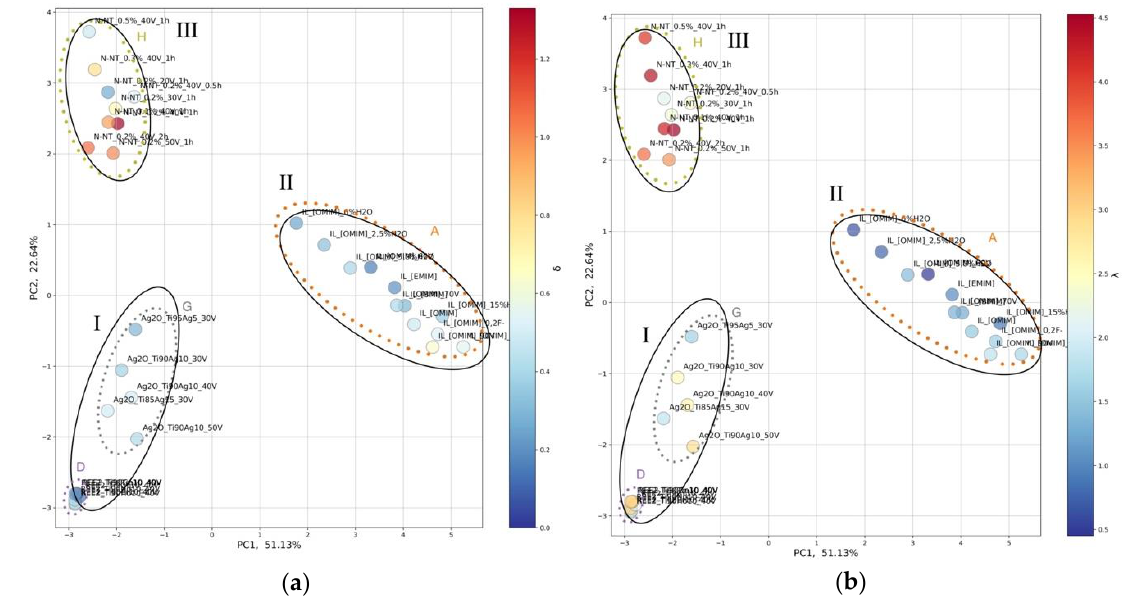
Figure 3. Score plots from the two PC analyses performed for 32 well-ordered TiO 2 -based NTs in the space of descriptors that represent experimental conditions and structural features of the investigated 32 well-ordered TiO 2 -based NTs for phenol photodegradation rate ( λ , µ mol · dm-3 · min-1) under ( a ) VIS and ( b ) UV-VIS light. Color codes: Values marked in blue and red determine the photocatalytic activity of selected samples.